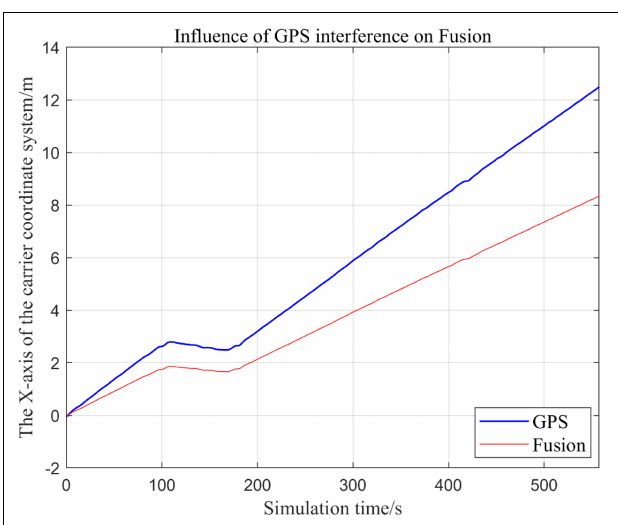
FIGURE 19 | Comparison of overall trajectory in x -axis after GPS failure and when all sensors are working